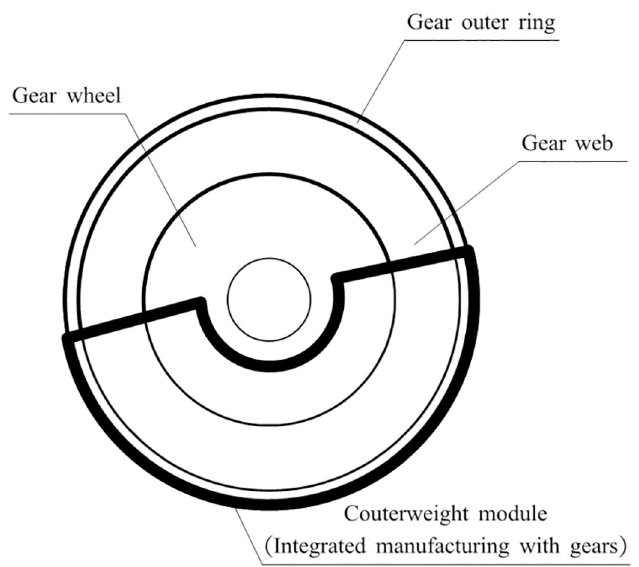
Fig 3. The structure of driven gear in the three-cylinder engine balancing